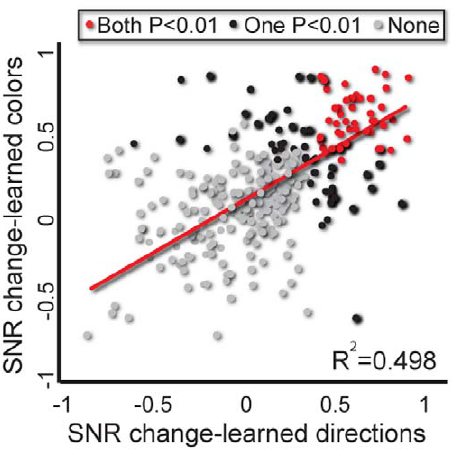
Figure 5. Simultaneous representation by single neurons after learning rotation and arbitrary association. Correlations between representation of the arbitrary association task (SNR change for target colors used during arbitrary association task) and the rotation task (SNR change for directions used during rotation task), by single neurons. Grey dots represent neurons that did not show significant changes, black dots represent neurons that showed significant SNR increases for only one of the tasks and red dots represent neurons whose